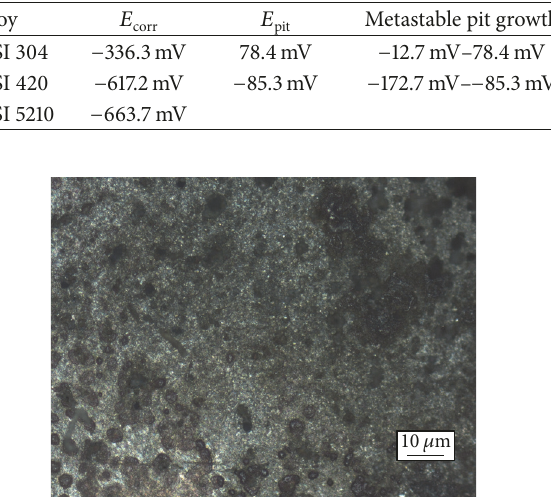
Figure 7: Microscope recordings of AISI 420 after polarization scan in 3.5 wt.% NaCl solution.